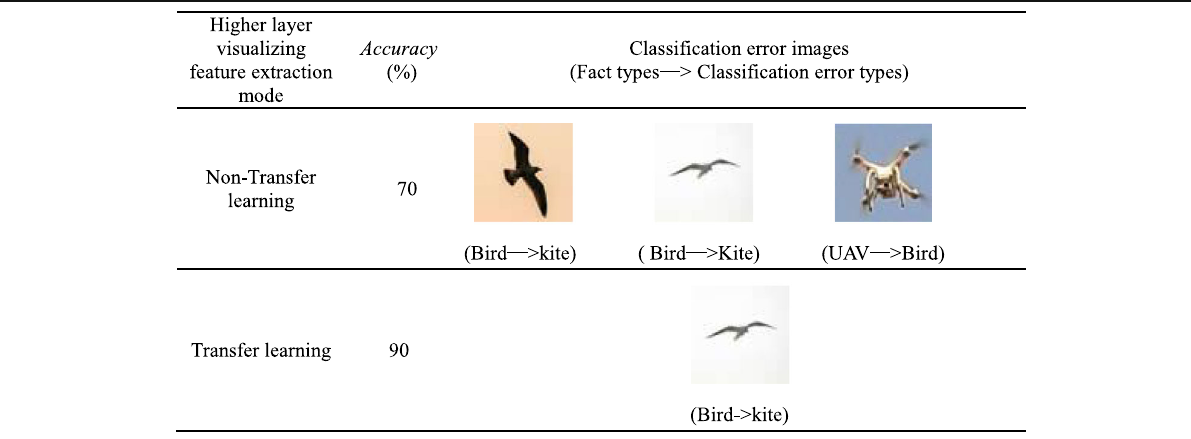
Table 4 Classification results in one